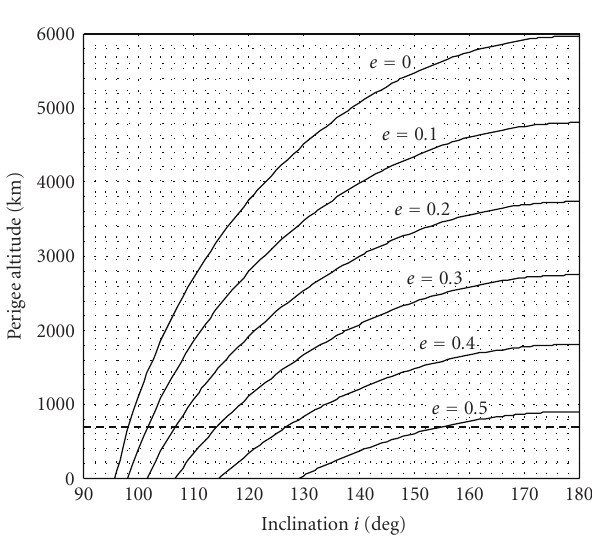
Figure 13: The orbit parameters limitations for a Sun-synchronous